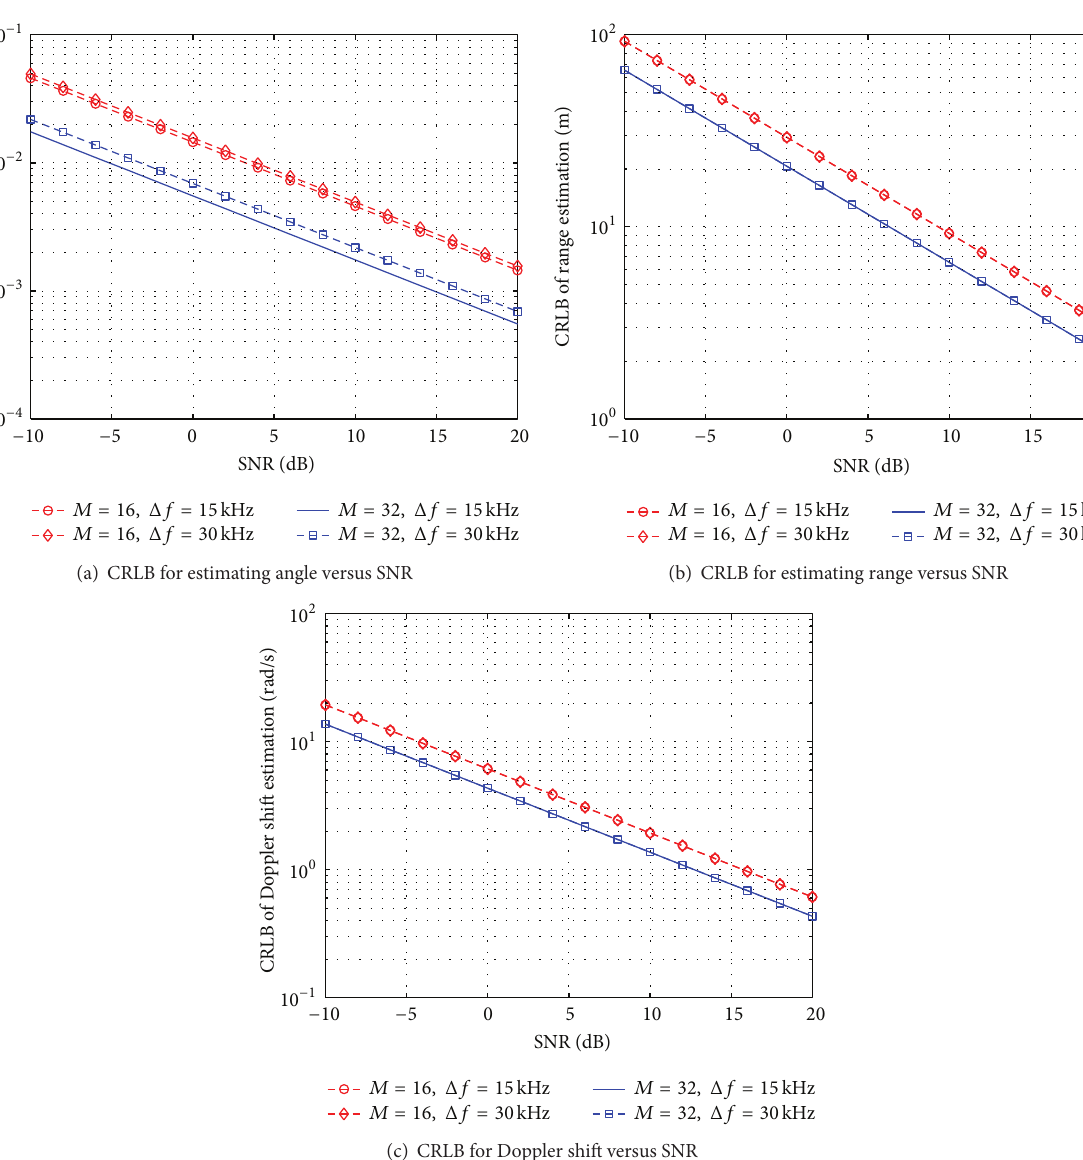
Figure 7: General CRLB results of FDA